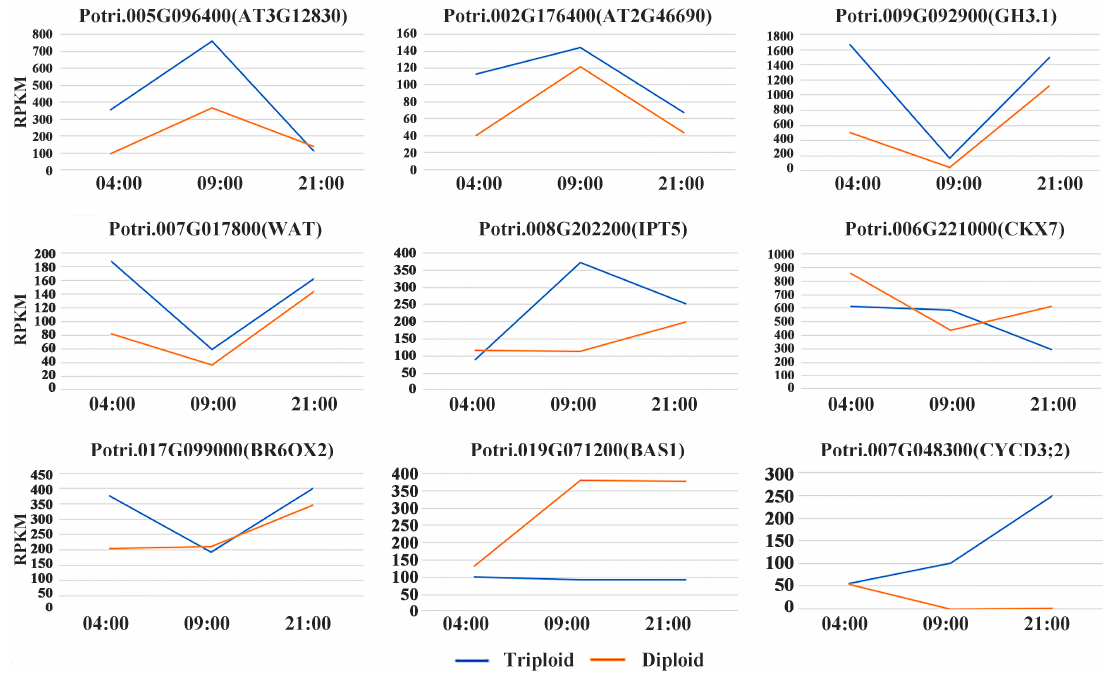
Figure 4. Distinct expression patterns of transcription factors and hormone-related genes between triploid and diploid leaves. Red lines represent the transcript levels in diploids; blue lines represent the transcript levels in triploids. Reads per kilobase of transcript per million (RPKM) were used to normalize the transcripts’ expression.